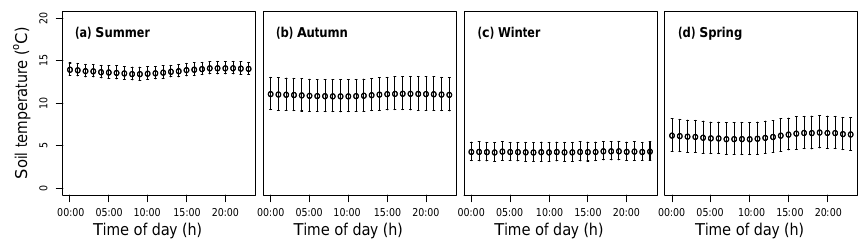
Figure 3. Seasonally averaged diurnal pattern of soil temperature ( ± standard deviation) at 5cm depth measured by six soil thermometers close to the eight automated chambers for summer (a) , autumn (b) , winter (c) and spring (d) .